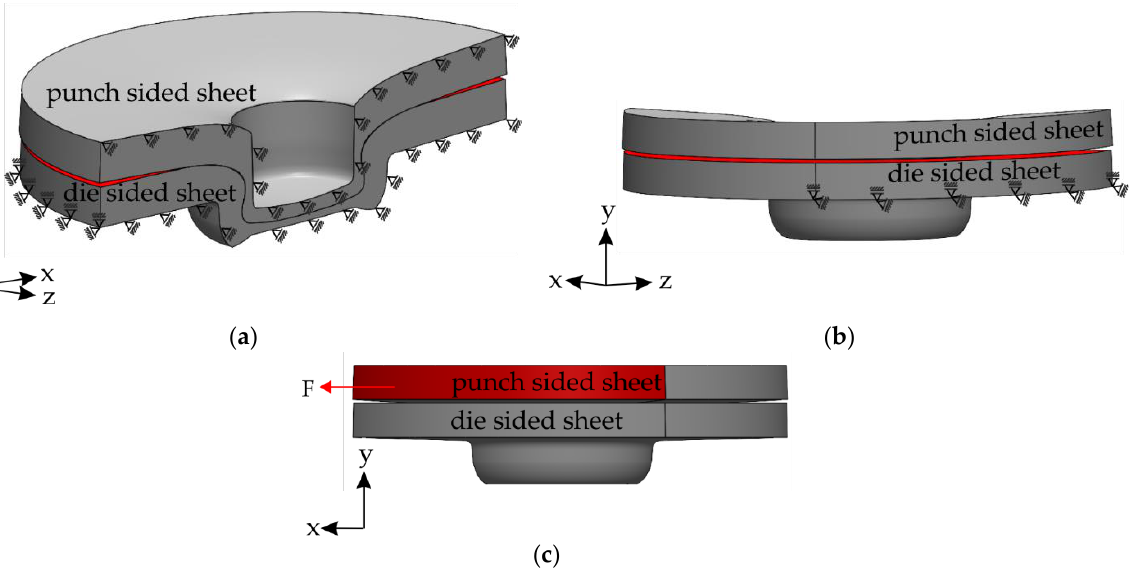
Figure 3. 3D model of clinched sheets prepared for crack growth simulation along with the boundary conditions: ( a ) The contact definition between the sheets (marked in red) and the boundary conditions on the punch-sided and die-sided sheets; ( b ) The contact definition between the sheets and the boundary conditions on the die-sided sheet in another view; ( c ) The loading situation on the punch-sided sheet.